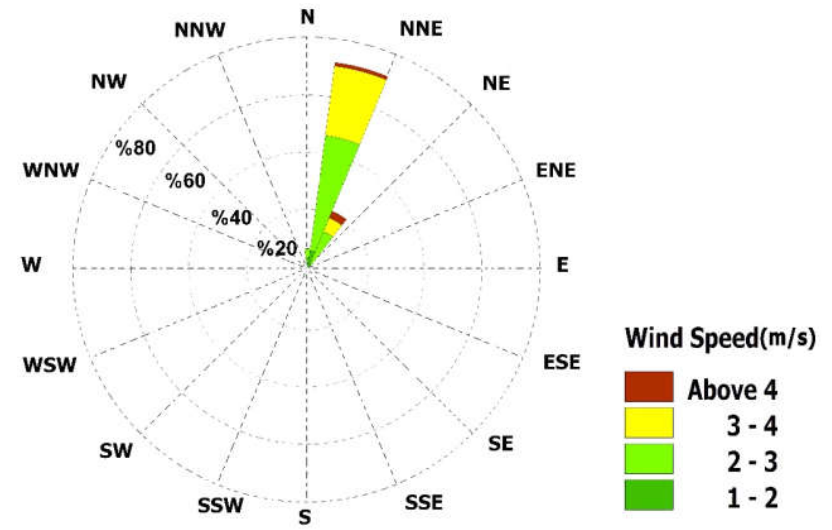
Figure 2. Wind rose for the Gulf of Oman in Kharif season (1981–2019).